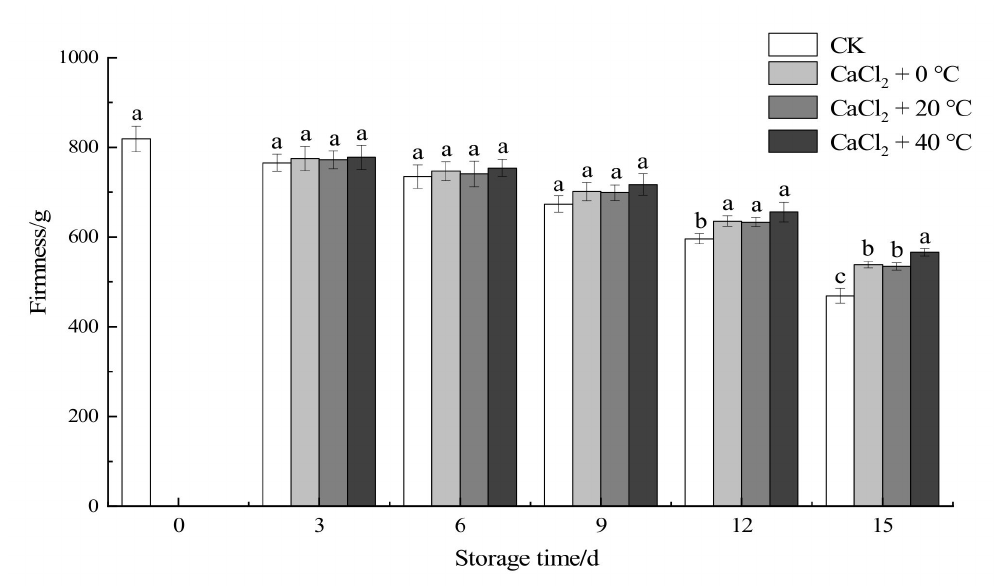
Figure 2. Effect of the different treatments on the firmness of fresh-cut “Xuebai” cauliflower florets. Error bars indicate standard deviation (SD); the statistical significance between the four groups that passed the Tukey significance test is expressed in different lowercase letters, and the significance level is p <